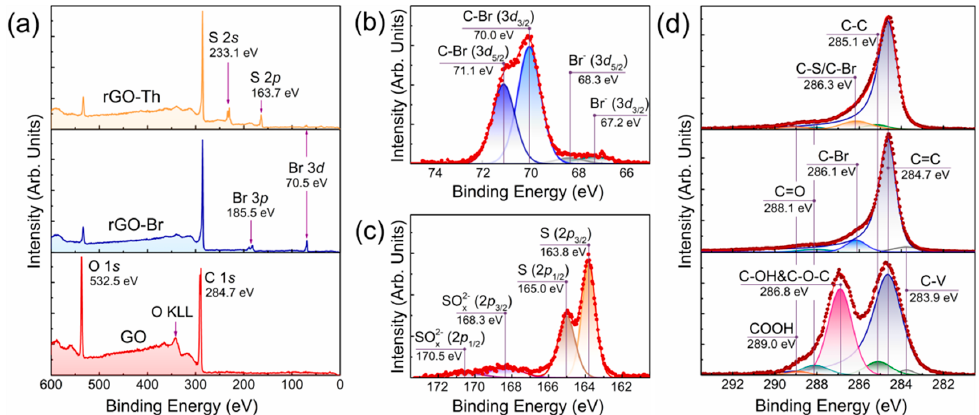
Figure 1. X-ray photoelectron examination of the CMGs’ chemistry. ( a ) Survey and core-level ( b ) Br 3 d , ( c ) S 2 p , ( d ) C 1 s X-ray photoelectron spectra of the initial GO, rGO–Br, and rGO–Th. The processed C 1 s X-ray photoelectron spectra displayed in Figure 1d further point out that the bromination and thiolation of the initial GO is accompanied by an intensive elimination of oxygen groups from the basal plane and edges of the graphene layer. Table